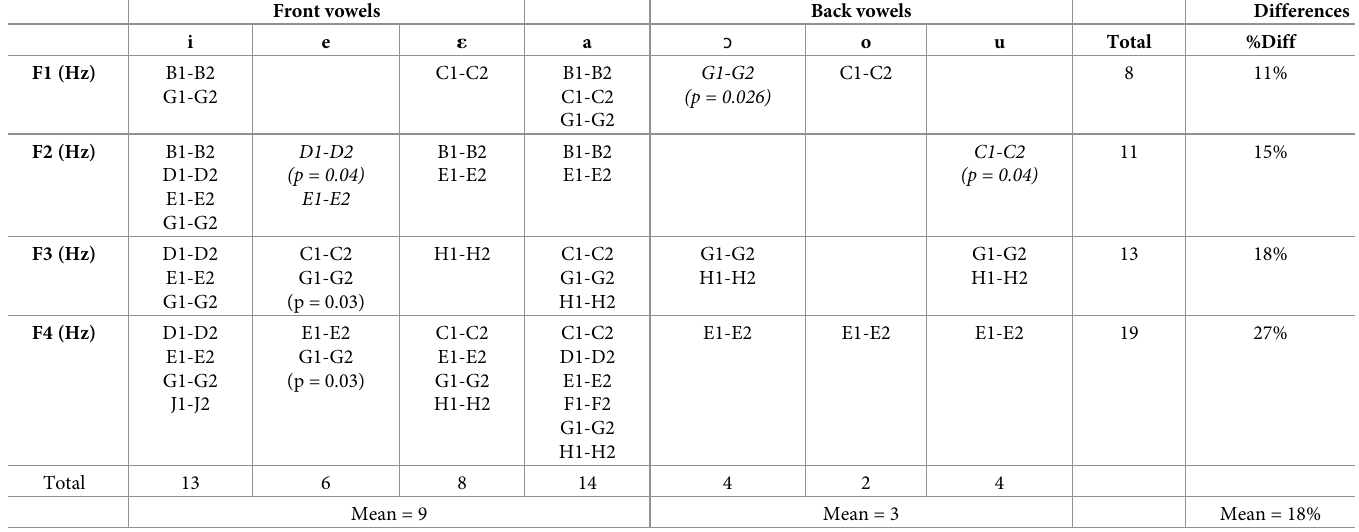
Table 1. Significant (p < 0.05/2) and marginally significant differences (p < 0.10/2) within identical twin pairs for comparisons considering both stressed and unstressed vowels. Two-tailed test with Bonferroni correction. Front vowels